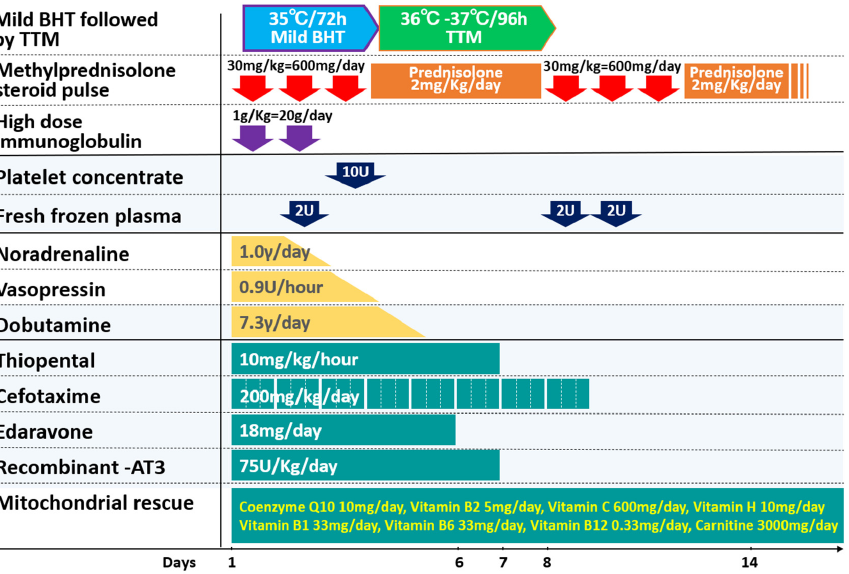
Figure 2. Brain hypothermia therapy is managed in the ICU followed by targeted temperature man- agement in the ICU or general ward [27]. BHT: Brain hypothermia; ICU: Intensive care unit; TTM: Targeted temperature management. Case description: A 4-year-old patient was immediately admit- ted to the intensive care unit. Within 4 h of symptom onset, she received mild-brain hypothermia therapy with a target body temperature of 35 °C for 48–72 h with ICU management. Methylpredni- solone pulse, high dose immunoglobulin, and large doses of circulatory drugs were administered. After 72 h of brain hypothermia therapy, targeted temperature management with a target body temperature between 36 °C and 37 °C was continued for 96 h while weaned from ventilation. Mag- netic resonance imaging results revealed no signs of acute encephalopathy. She was discharged without neurological sequelae 28 d after symptom onset. A retrospective study of children with acute encephalopathy and serum aspartate aminotransferase levels below 90 IU/l within 6 h of onset (N = 57 children) evaluated the effectiveness of TTM. Grade 1 in Pediatric Cerebral Performance Category Scale , representing good clinical outcomes, was observed in 67% of the children [21]. Another retrospective study compared the clinical course and outcome in 20 children treated with TTM (36 °C) and methylprednisolone pulse (MP) therapy (TTM/MP) with those treated with conven- tional MP therapy in a secondary emergency care hospital. All children treated with TTM/MP survived, and their body temperature dropped quickly. Some cases of acute en- cephalopathy are of the so-called fulminant kind, in which DIC or shock manifests quickly after the start, making it occasionally challenging to administer TTM. Patients of the ful- minant variety need to be taken to tertiary emergency care facilities. Secondary emergency care facilities must carefully choose patients for TTM while considering the likelihood of evacuation to a tertiary emergency facility [46]. Table 2 summarizes the evidence for TTM or BHT in acute encephalopathy, and Table 3 summarizes the BHT protocol at our center.